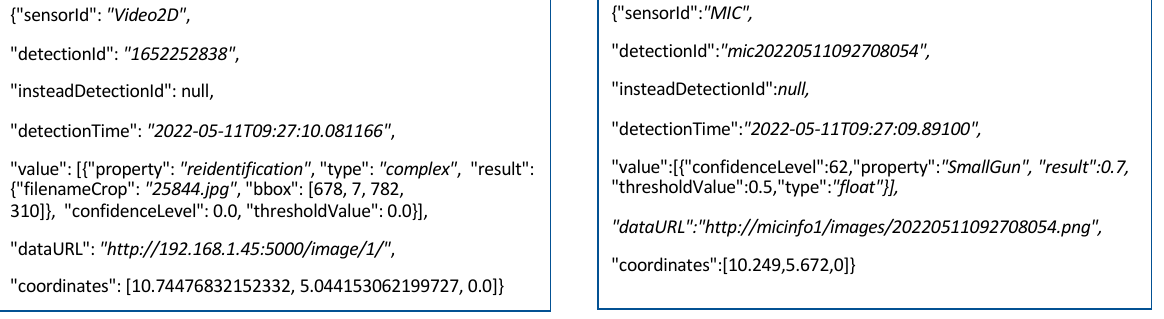
Figure 9. MIC ( left ) and 2D Video ( right ) JSON messages generated during the BCT trials.